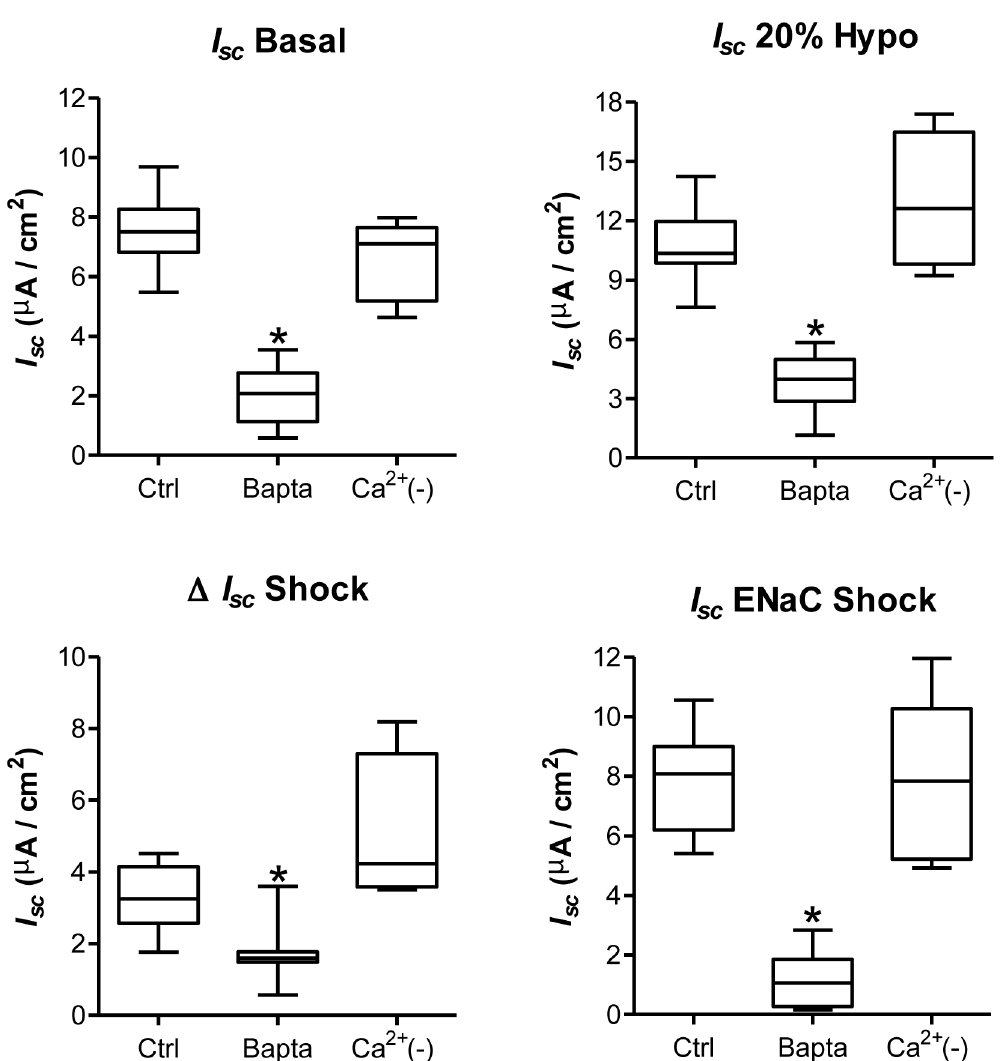
Figure 8. Implication of Ca 2+ in basal and hypotonic-induced transepithelial current. Basal transepithelial current ( I hypotonic-induced current ( I 20% Hypo), the current rise elicited by hypotonic shock (Δ I sc current recorded after hypotonic shock ( I ENaC Shock) are depicted in basal condition (Ctrl), after treatment for 20 min with 50 µM sc BAPTA-AM (Bapta) or in a physiological buffer devoid of Ca 2+ (Ca 2+ (-)). N≥5, *p<0.05 by Mann-Whitney Test compared to untreated